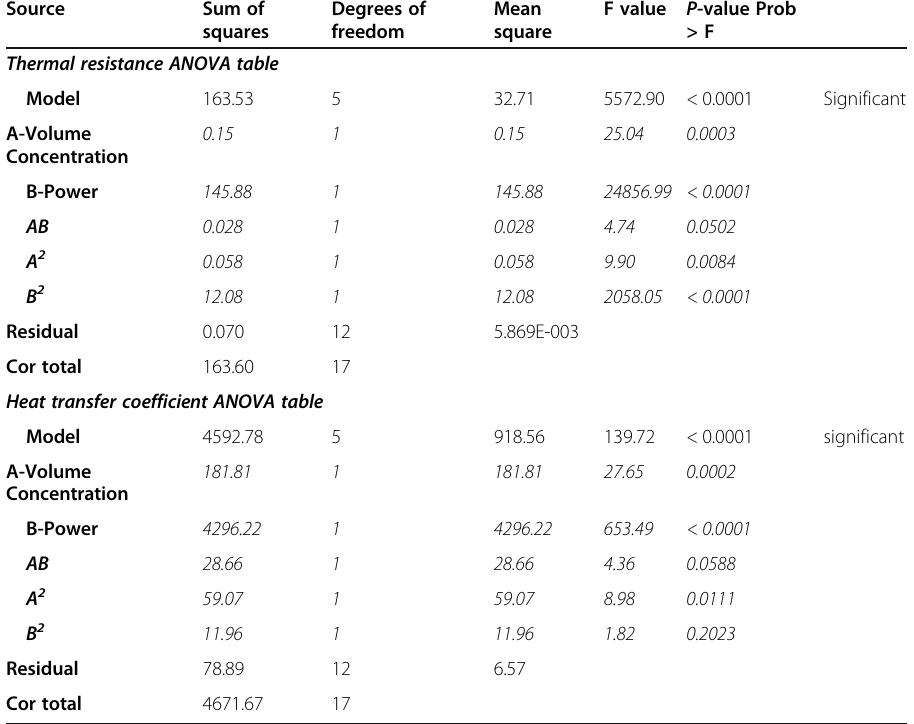
Table 3 Analysis of variance of all responses